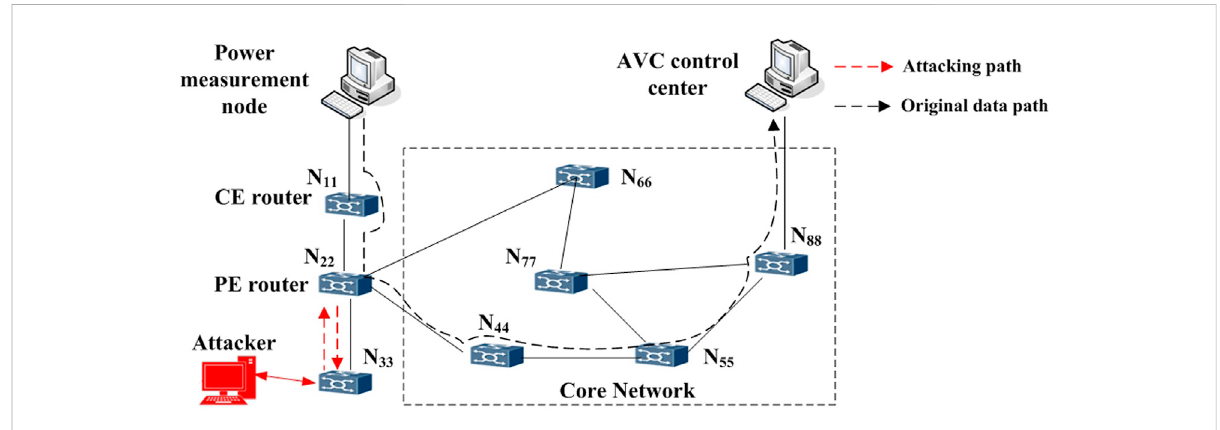
FIGURE 4 The topology of communication network for AVC